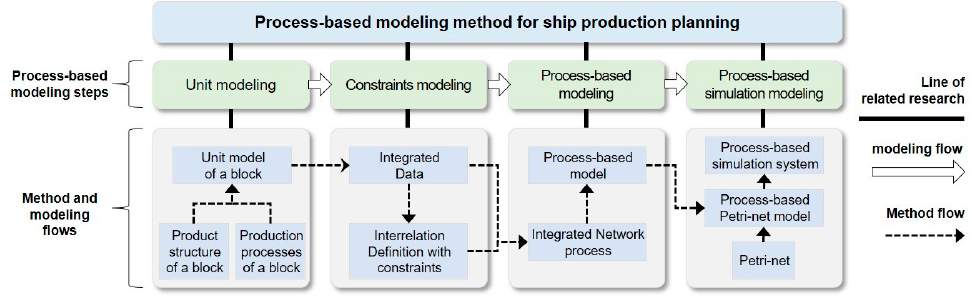
Figure 2. Overall flow of the process-based modeling methods for ship production planning.